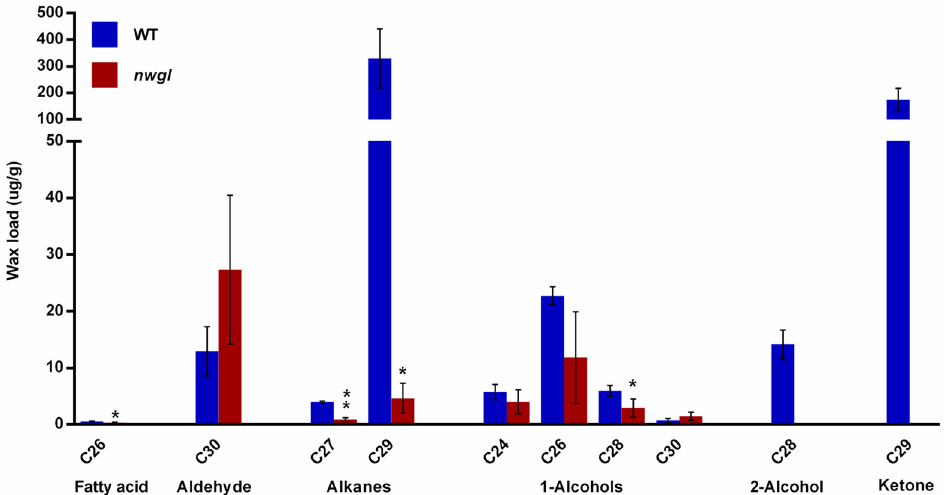
Table 1. Cuticular wax composition of leaf blades from wild-type and nwgl plants.